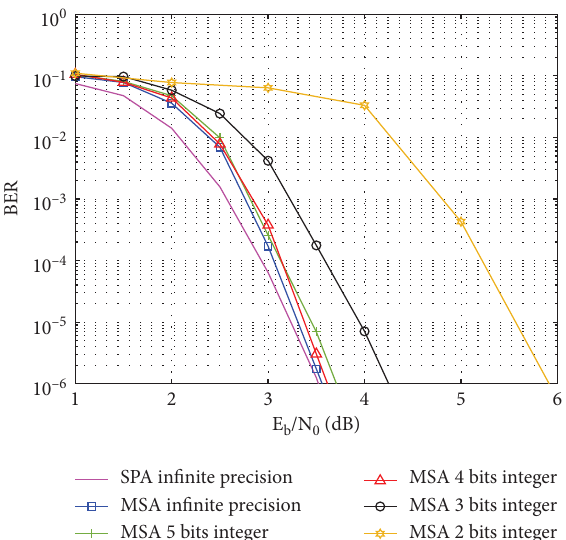
Figure 13: BER performance of MSA decoding for shortening LDPC codes. Te solid lines represent infnite precision and the dashed lines mean integer quantization.